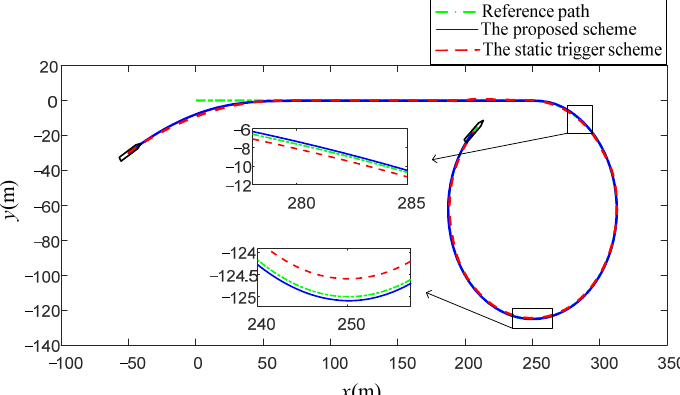
Figure 9. The comparative results under the 2-D platform.